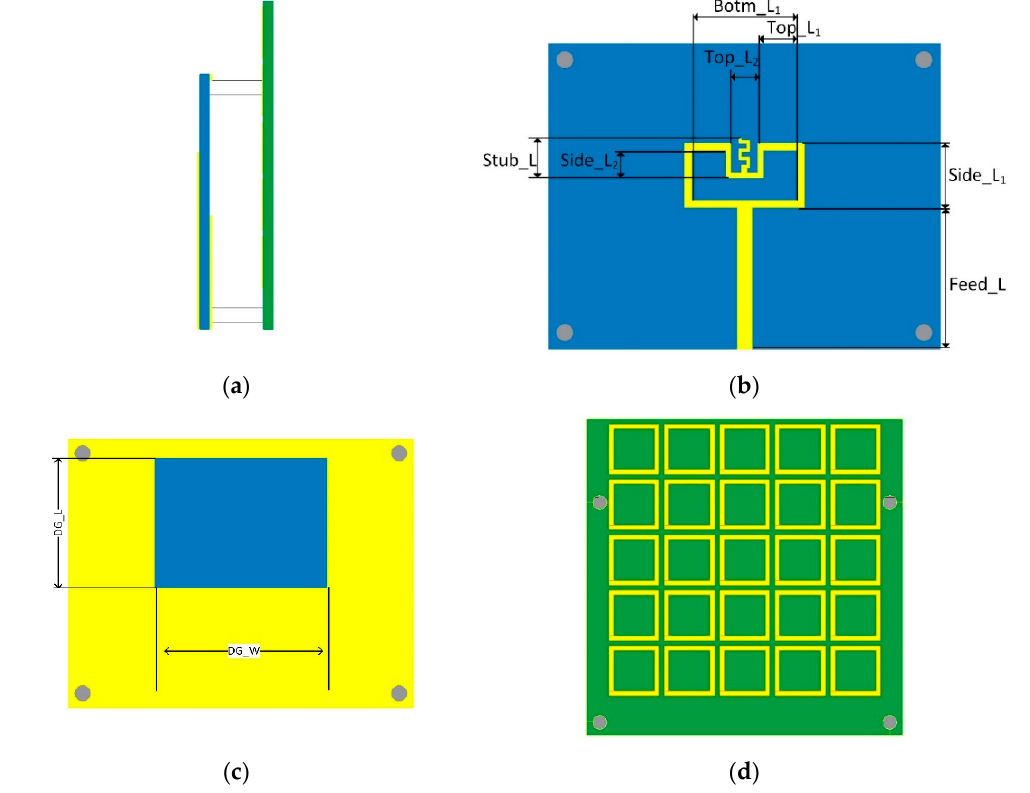
Figure 1. Configuration of antenna: ( a ) side view, ( b ) first layer top view, ( c ) first layer bottom view, ( d ) second layer.